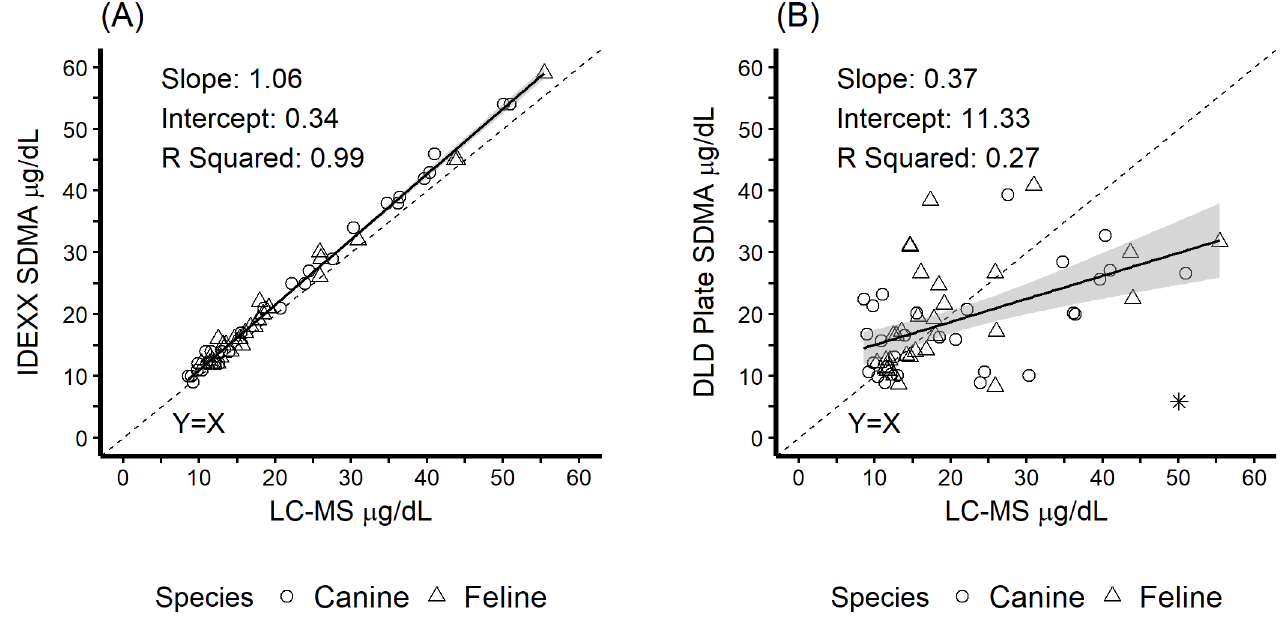
Fig 1. Accuracy of two SDMA diagnostic methods compared to the reference standard (LC-MS). (A) The IDEXX SDMA Test. (B) The DLD SDMA ELISA method. Solid line represents best fit linear model; shading represents 95% confidence interval around the line. Dashed line is the line of equality. Outliers are represented by �